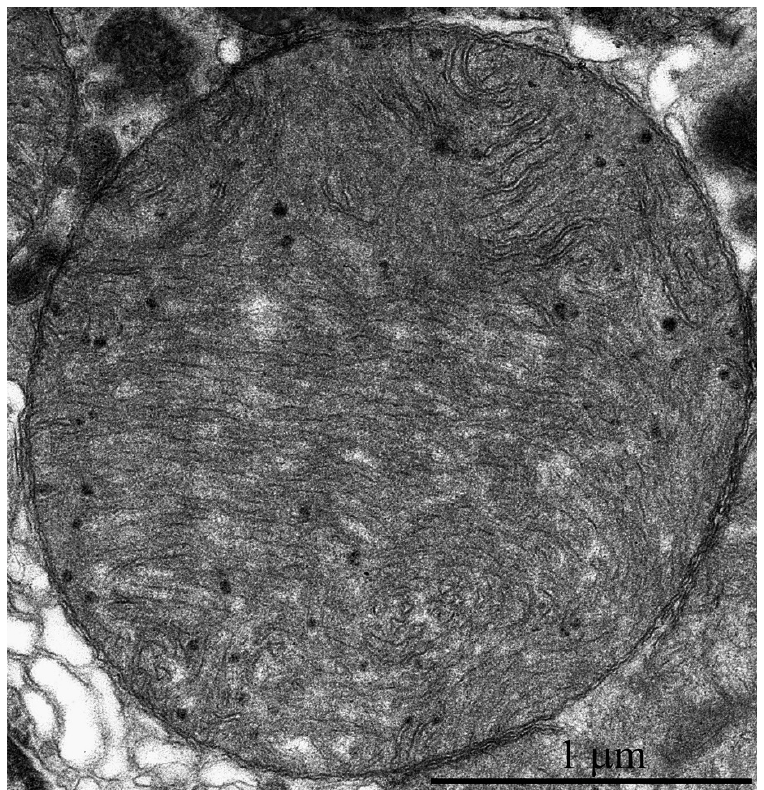
Figure 7. Electron microscopic image of the ultrastructural features of a large mitochondrion from a left ventricular cardiomyocyte from 11-year-old naked mole rat.